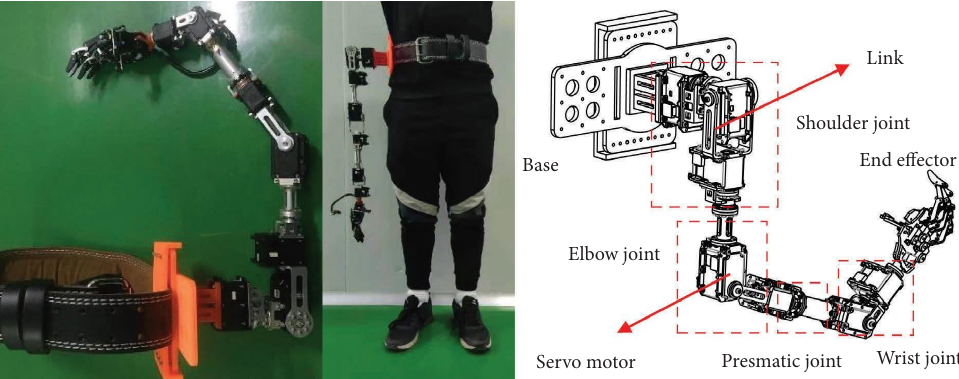
Figure 5: Te SRL prototype.